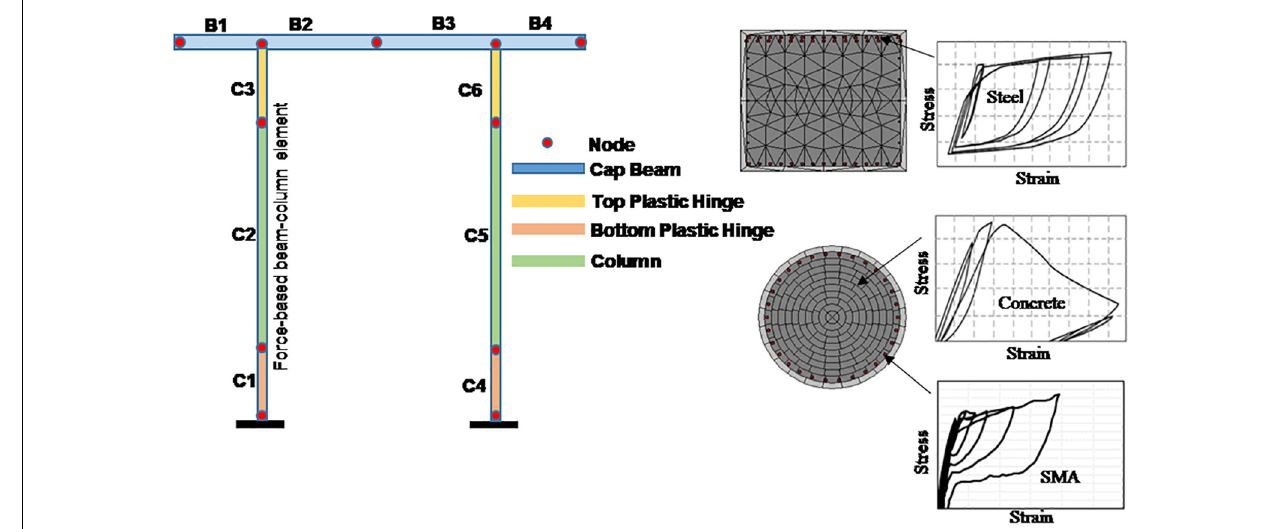
FIGURE 7 | Idealized numerical bridge bent model and fiber discretized cross section.